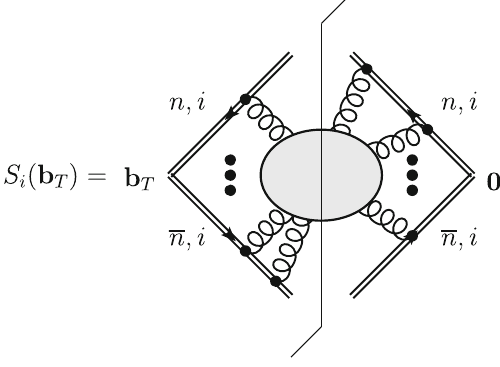
Fig. 2 Graphical representation of the soft function defined in Eq. (3)